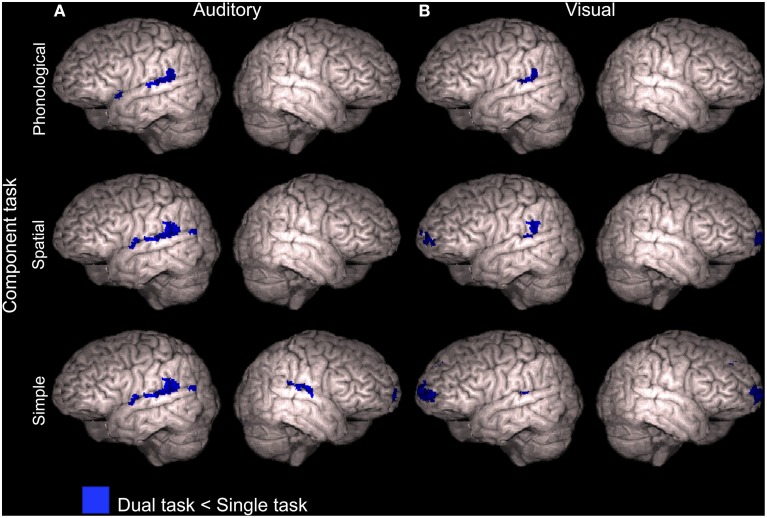
Activity decrements during dual tasks in relation to single tasks. Areas showing lower activity (Z > 2.3, cluster corrected P < 0.05) during dual tasks than during the component tasks performed separately in our previous study (Salo et al., 2013). (A) Dual tasks including the auditory phonological (APhonVPhon, APhonVSpat, and APhonVSimp), spatial (ASpatVPhon, ASpatVSpat, and ASpatVSimp) or simple (ASimpVPhon, ASimpVSpat, and ASimpVSimp) component task compared with corresponding auditory component tasks (APhon, ASpat, and ASimp, respectively). (B) Dual tasks including the visual phonological (APhonVPhon, ASpatVPhon, and ASimpVPhon), spatial (APhonVSpat, ASpatVSpat, and ASimpVSpat) or simple (APhonVSimp, ASpatVSimp, and ASimpVSimp) component task compared with corresponding visual component tasks (VPhon, VSpat, and VSimp, respectively). Note that the brain images are tilted 20° to the left or right to reveal ventromedial brain areas.